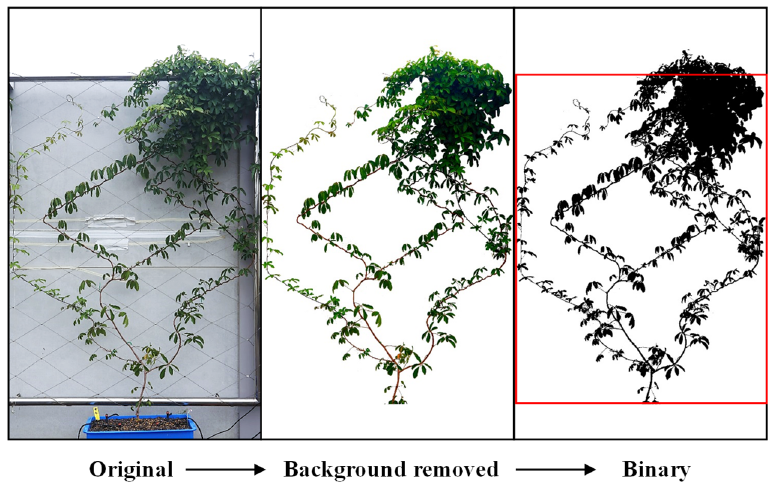
Figure 1. Image processed for measuring percentage wall coverage. The binary image (black pixels) of the same individual was used to calculate the percentage wall coverage. Red outline indicates the area of the wall (1.45 m (W) × 1.95 m (H)) that was examined to determine the percentage wall coverage.